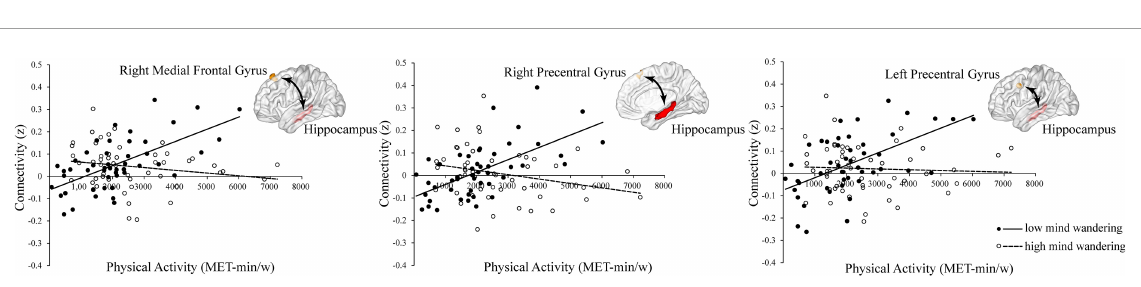
TABLE 3 Mind wandering modulated the relationship between physical activity and hippocampal functional connectivity. Z Cluster size Peak MNI coordinates Polarity x y z Regions showing significant connectivity in high mind wandering group ( N = 48) Left precuneus − 3.974 - Right precentral gyrus − 4.026 - Regions showing significant connectivity in low mind wandering group ( N = 51) Right medial frontal gyrus Right precentral